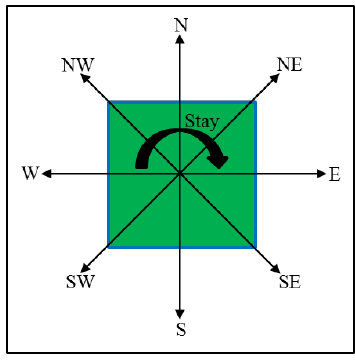
Figure 11. Nine cardinal directions for vacant taxi movement.